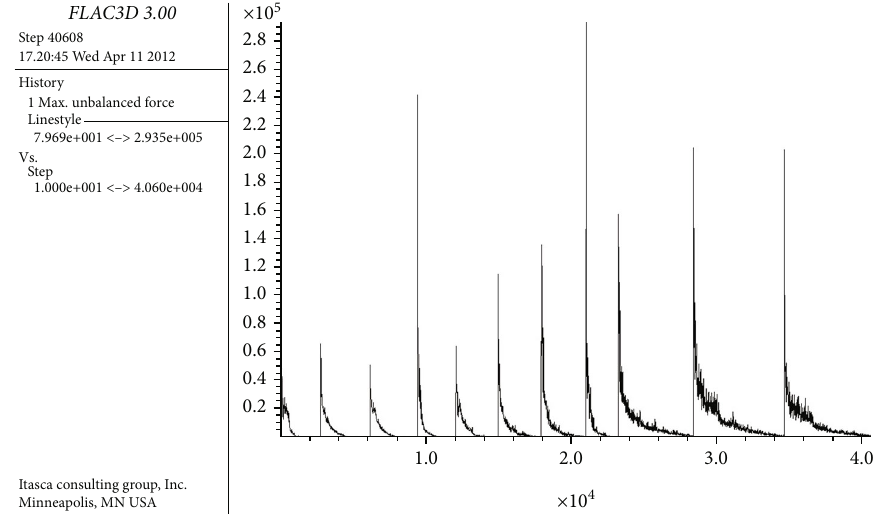
Figure 5: Evolution curve of maximum unbalanced force with a calculation time step.